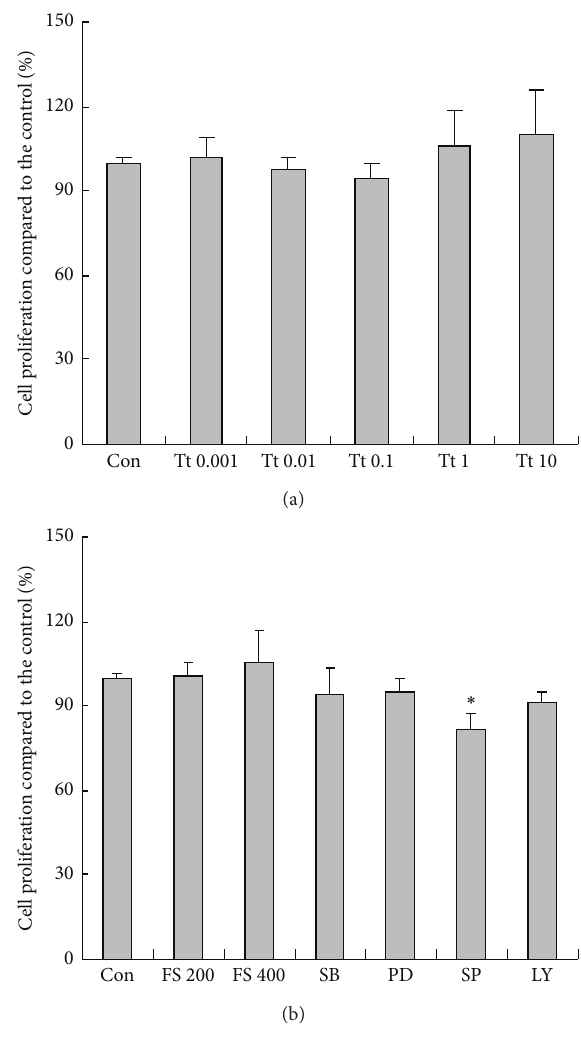
Figure 1: Effects of tryptase (Tt) and specific inhibitor of PAR-2 or MAPKs on the viability of astrocytes. For the dose-dependent studies astrocytes were treated with either culture medium only or various concentrations of tryptase (0.001, 0.01, 0.1, 1, and 10 𝜇 g/mL), FSLLRY-NH2(FS,200or400 𝜇 M),SB203580(SB,20 𝜇 M),PD98059 (PD, 20 𝜇 M), SP600125 (SP, 20 𝜇 M) and LY294002 (LY, 20 𝜇 M) for 24 h. Data are presented as the mean ± SEM in triplicate on four separate occasions. ∗ 𝑃 < 0.05 versus control groups